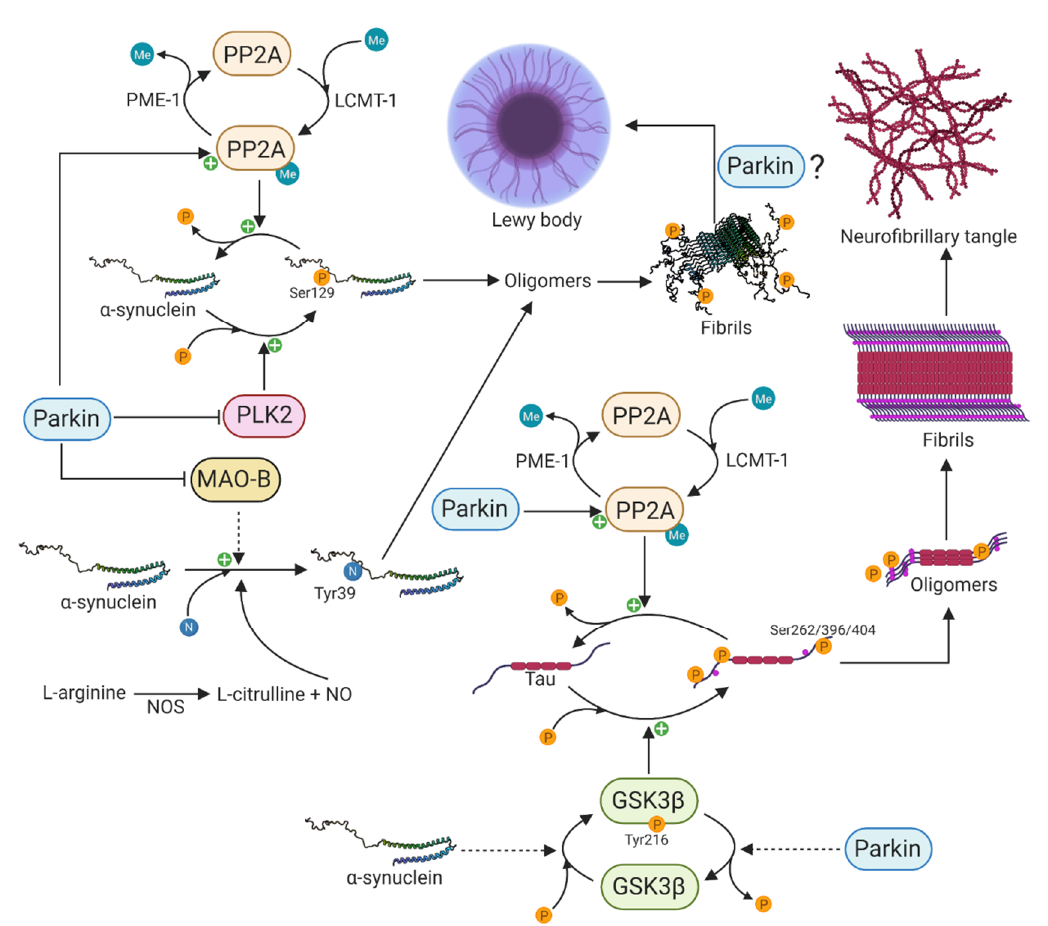
Figure 3. Functional interaction between α -synuclein and parkin in protein aggregation. Parkin can prevent protein aggre- gation and neurofibrillary tangles through its activation of PP2A. PP2A is able to dephosphorylate both pSer262/396/404 tau and pSer129 α -synuclein, thereby attenuating the formation of toxic oligomers and eventually Lewy bodies and neurofibrillary tangles. Parkin is also able to inhibit the activity of PLK2 that normally phosphorylates α -synuclein on serine 129. Inhibition of MAO-B by parkin results in decreased oxidative stress and decreased formation of Tyr39 nitrated α -synuclein and oligomer formation. Parkin and α -synuclein have opposite functions regarding the activity of the major kinase GSK3 β that phosphorylates tau. The phosphorylation of GSK3 β at Tyr216 is dependent on α -synuclein, whereas its dephosphorylation is indirectly regulated by parkin. Created with